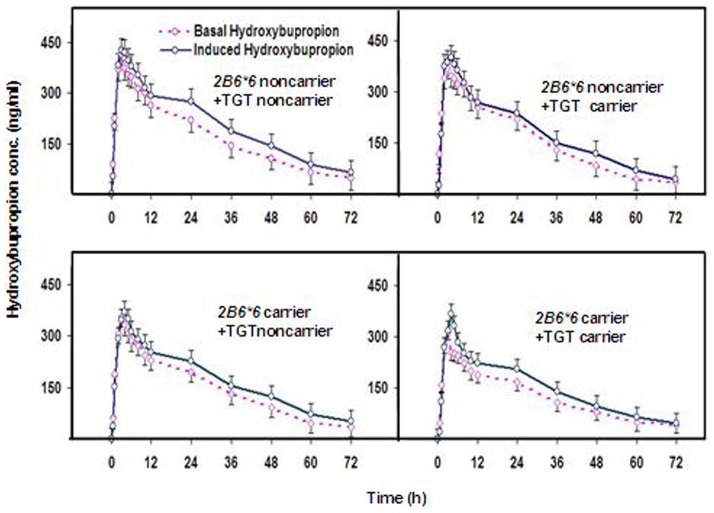
Concentration (conc.)–time profiles of hydroxybupropion.Mean plasma concentration-time profiles of hydroxybupropion after oral administration of 150 mg of bupropion or bupropion+SF treatment in subjects after 14 days in the NR1I2 and CYP2B6 genotype groups.